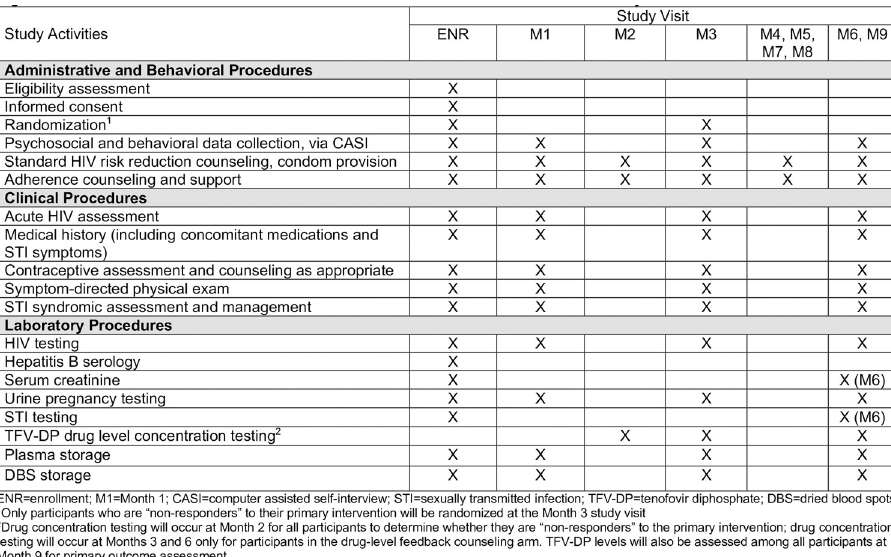
Fig 1. Schedule of enrollment, interventions, and assessments for PrEP SMART study. ENR = enrollment; M1 = Month 1; CASI = computer assisted self-interview; STI = sexually transmitted infection; TFV-DP = tenofovir diphosphate; DBS = dried blood spots. 1 Only participants who are “non-responders” to their primary intervention will be randomized at the Month 3 study visit. 2 Drug concentration testing will occur at Month 2 for all participants to determine whether they are “non-responders” to the primary intervention; drug concentration testing will occur at Months 3 and 6 only for participants in the drug-level feedback counseling arm. TFV-DP levels will also be assessed among all participants at Month 9 for primary outcome assessment.